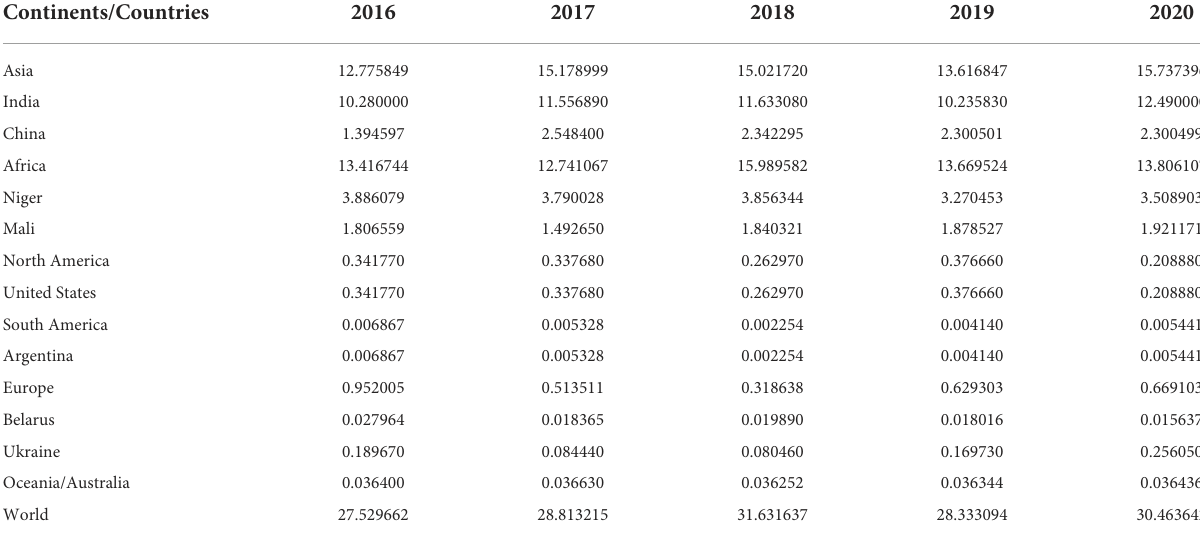
TABLE 1 Country wise production of millets in million tons (2016–2020).